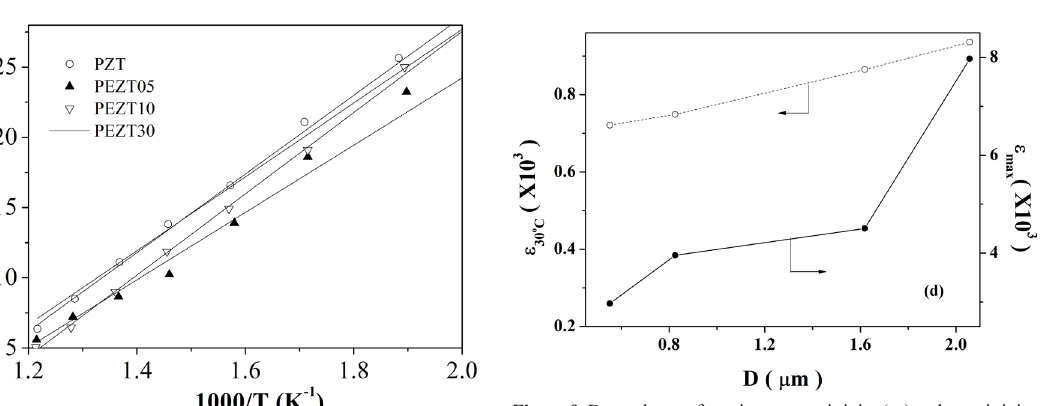
Figure 9. Dependence of maximum permittivity (ε at a temperature at 30 o C (ε 30o materials studied.